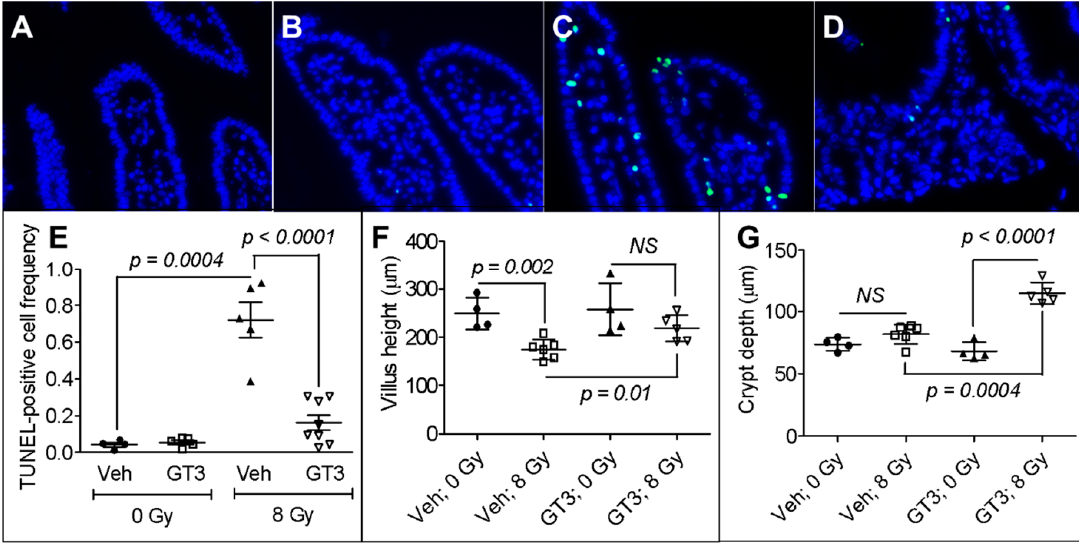
Figure 1. Effects of gamma-tocotrienol (GT3) pretreatment on total body irradiation (TBI)-induced intestinal damage. Representative photomicrograph of TUNEL-positive cells (green) in ( A ) vehicle (veh) un-irradiated, ( B ) GT3 un-irradiated, ( C ) vehicle irradiated, and ( D ) GT3 irradiated groups. ( E ) Frequency of TUNEL-positive cells in the intestine of sham-irradiated or irradiated mice, with or without GT3 pretreatment, TUNEL-positive cells were counted 24 h after 8 Gy TBI; ( F ) Villus height measured 4 d after 8 Gy TBI in sham-irradiated or irradiated groups, with or without GT3 pretreatment; ( G ) Crypt depth measured 4 d after 8 Gy TBI in sham-irradiated or irradiated groups, with or without GT3 pretreatment. Data represent the mean ± standard error of the mean (SEM). NS = not significant.